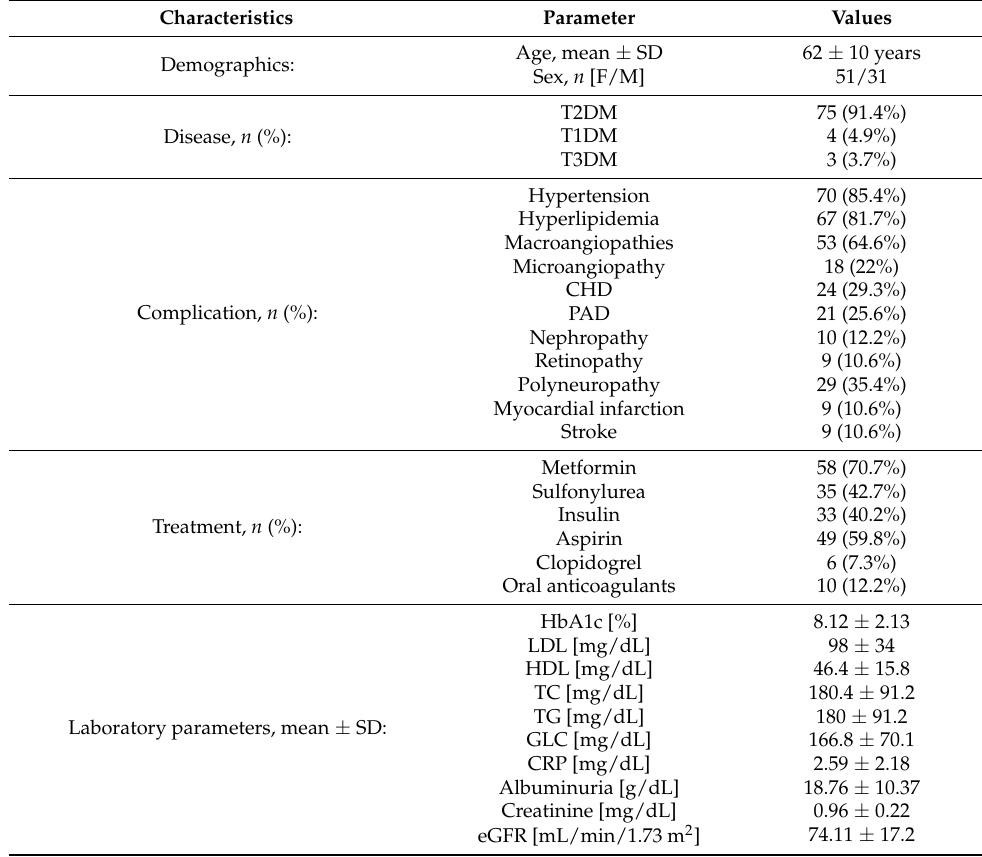
Table 1. Characteristics of studied population.